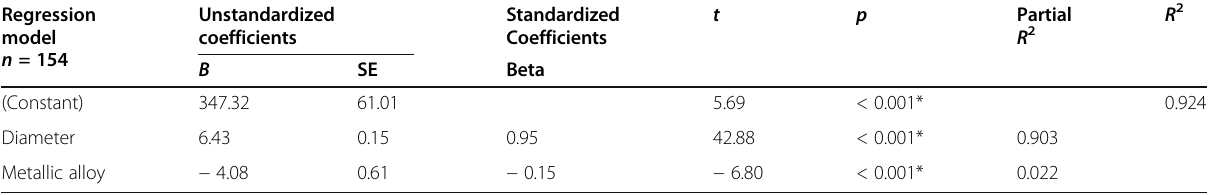
Table 2 Influence of MI diameter and metallic alloy on the fracture torque (multiple linear regression analysis) Regression model